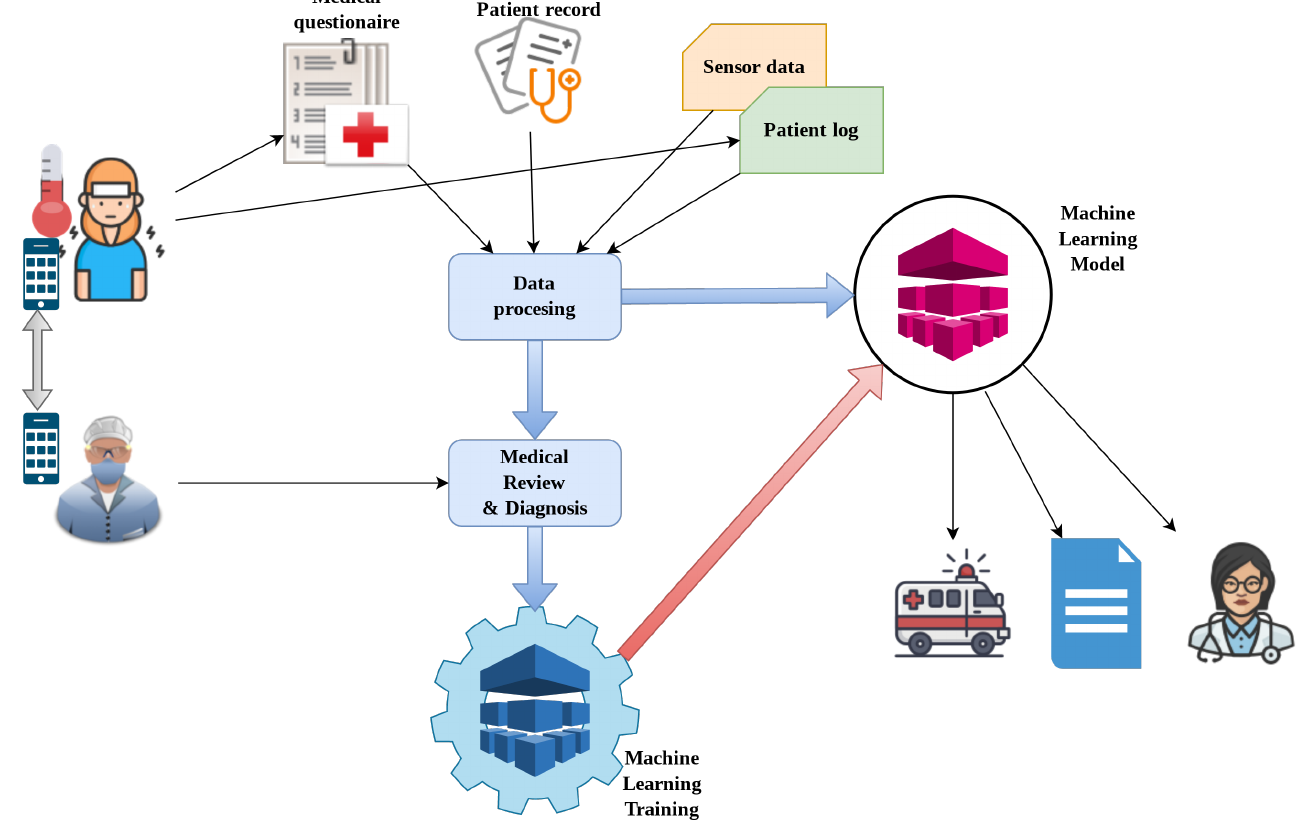
Figure 3. High-level data collection and service delivery